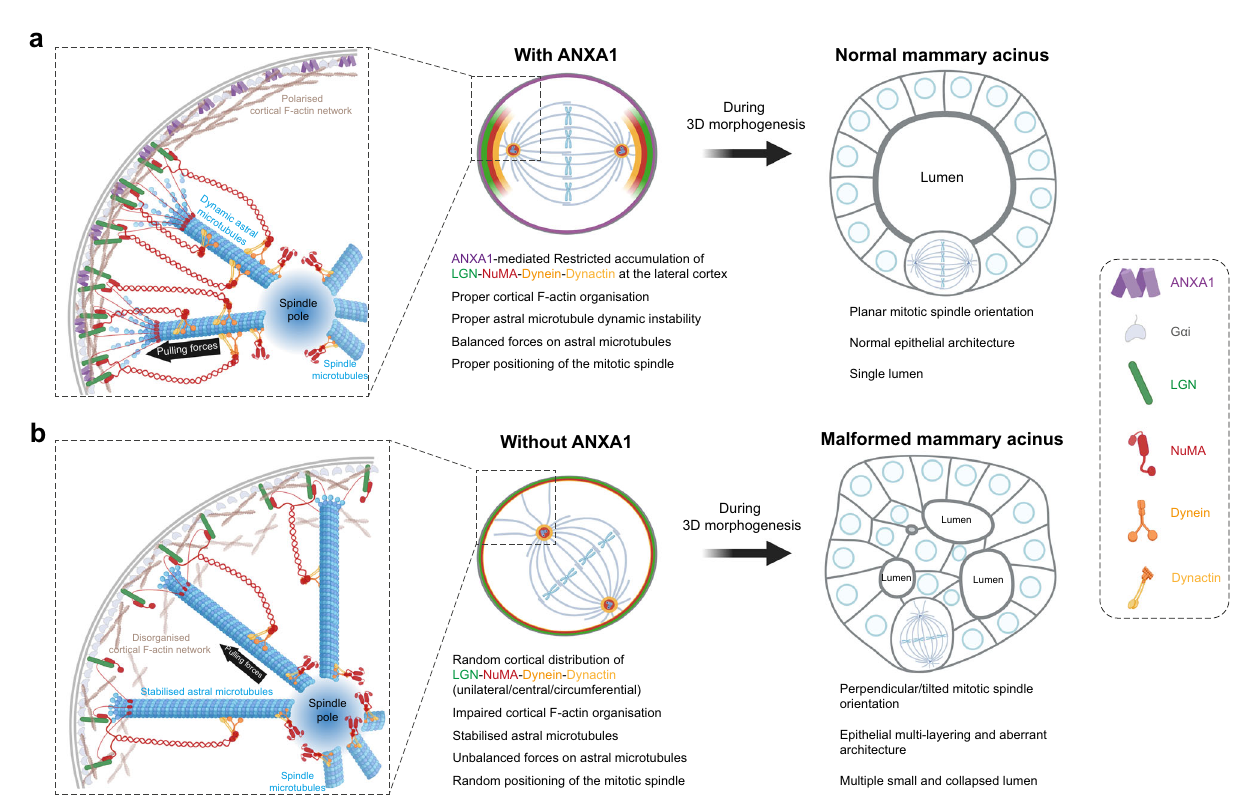
Fig. 7 | Proposed model for ANXA1 regulation of planar mitotic spindle orien- tation and epithelial morphogenesis. a Cortical ANXA1 interacts with LGN to instruct polarised accumulation of the LGN-NuMA complex at the lateral cortex. NuMA in turn, recruits Dynein-Dynactin generating pulling forces on the spindle poles that are balanced by ANXA1-dependent regulation of cortical F-actin and astral microtubule organisation, thereby ensuring planar alignment of the mitotic spindle.During 3Dmorphogenesis, ANXA1-dependent regulation ofplanarmitotic spindle orientation is crucial for single lumen formation and normal epithelial